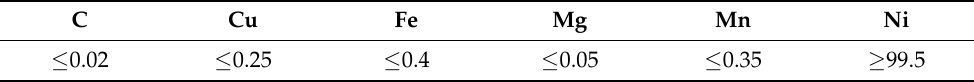
Table 1. Chemical composition (wt %) of the investigated Nickel 200 alloy. C Cu Fe Mg Mn Ni ≤ 0.02 ≤ 0.25 ≤ 0.4 ≤